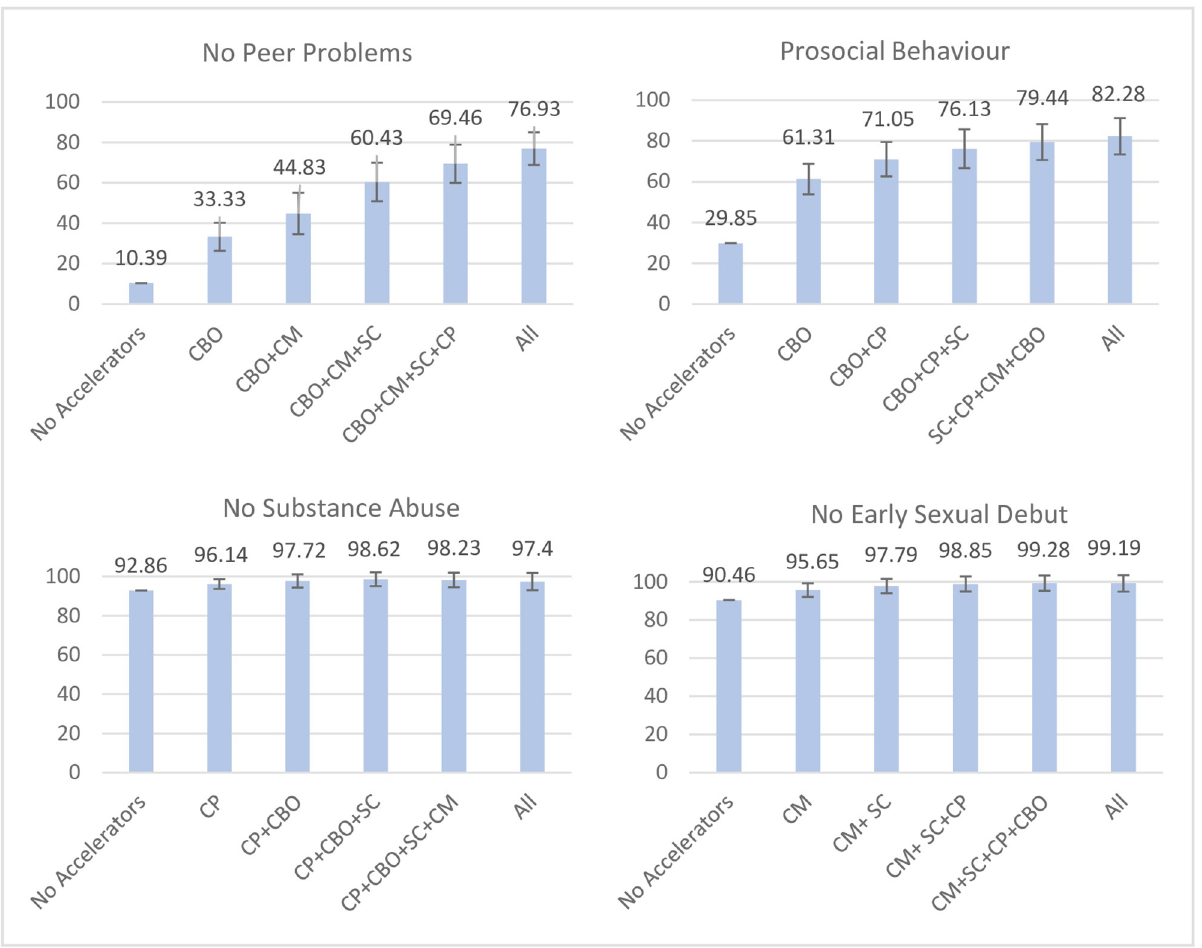
Fig 2. Accelerator combinations leading to the strongest changes in adjusted probabilities for each behavioural outcome. Figure scales adjusted based on range of outcome values. CBO = Access to community-based organisations, SC = Living in a Safe Community, CP = Caregiver Praise, FS = Food security, CM = Caregiver Monitoring. 95% confidence intervals